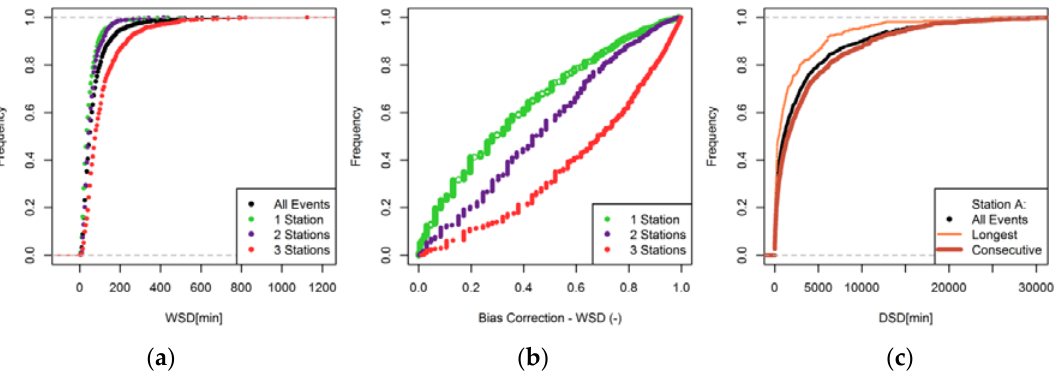
Figure 7. ( a ) Cumulative distributions of WSD, ( b ) bias correction of WSD, and ( c ) cumulative distributions of DSD for summer events corresponding to BAWU_A case.